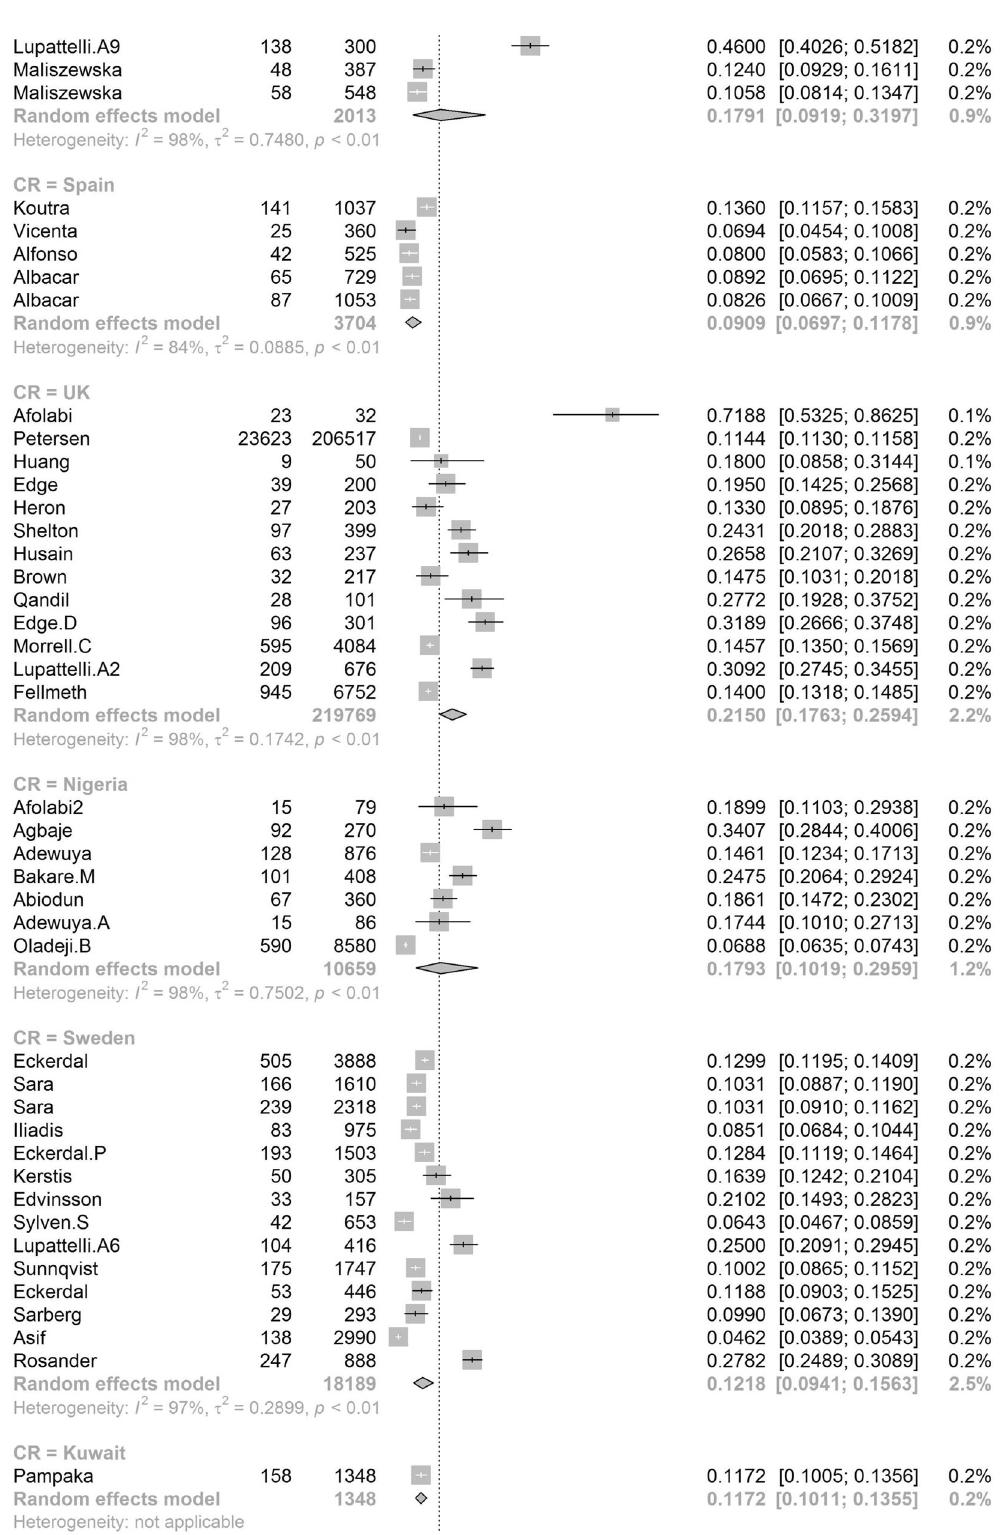
experience feelings of helplessness and despair, as well being at high risk to commit suicide. Unexpectedly, in our meta-analysis, an